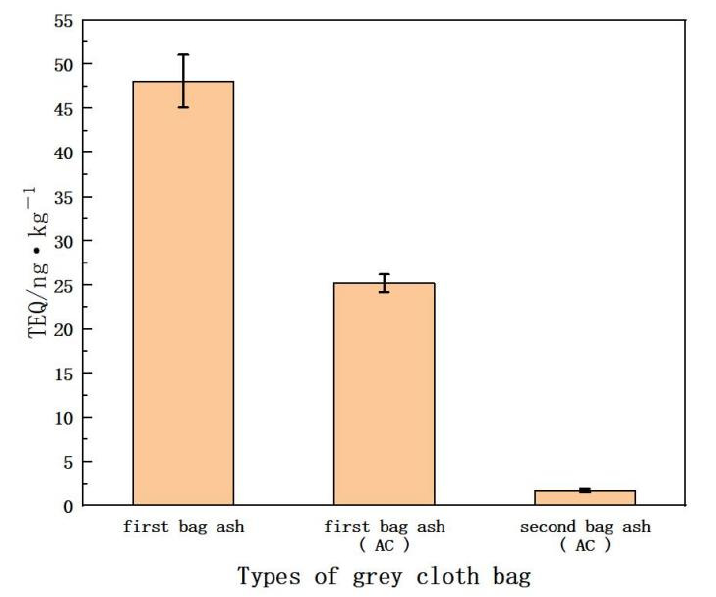
Figure 2. Dioxin TEQ concentrations from the fly ash samples.